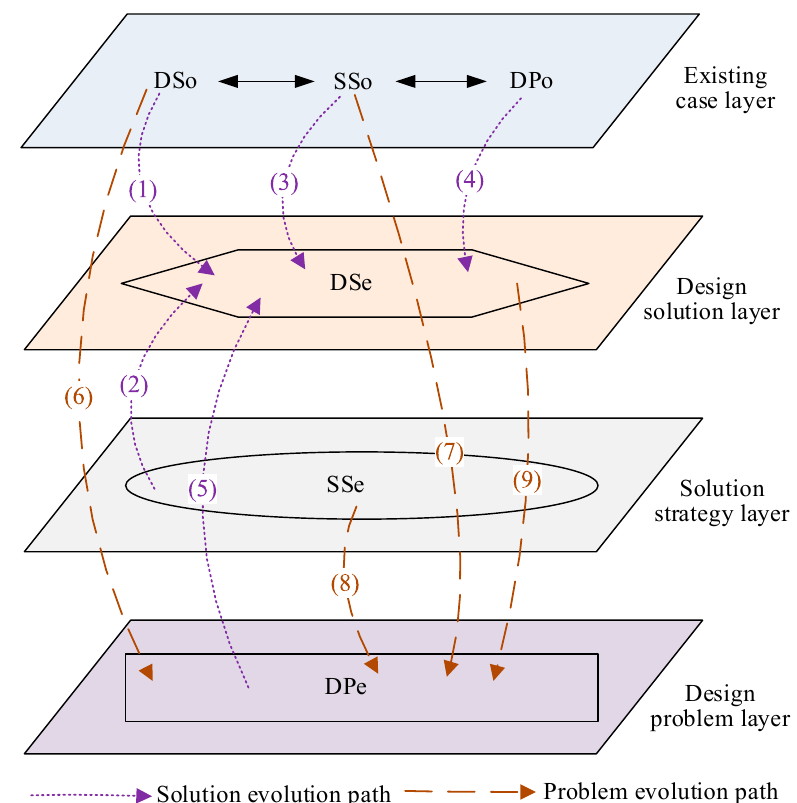
Figure 3. Evolution process of PSS-based product design solution.